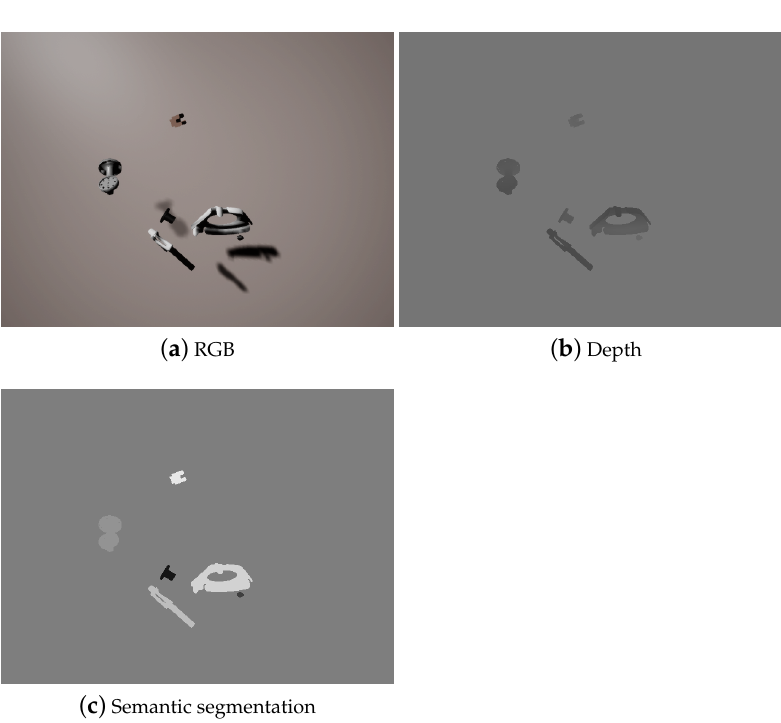
Figure 6. Output images from the UE4. Depth image has been adapted for